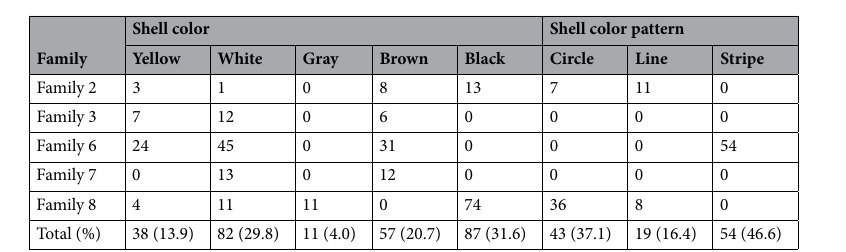
Figure 4. Photograph composition showing representative individuals of the five families (F2, F3, F6, F7 and F8) of C . edule used for GWAS on shell color and pattern. Last panel: summary of the variation within and between families: yellow (1), white (2), gray (3), brown (4), black (5), circle (7), line (8) and stripe (9).